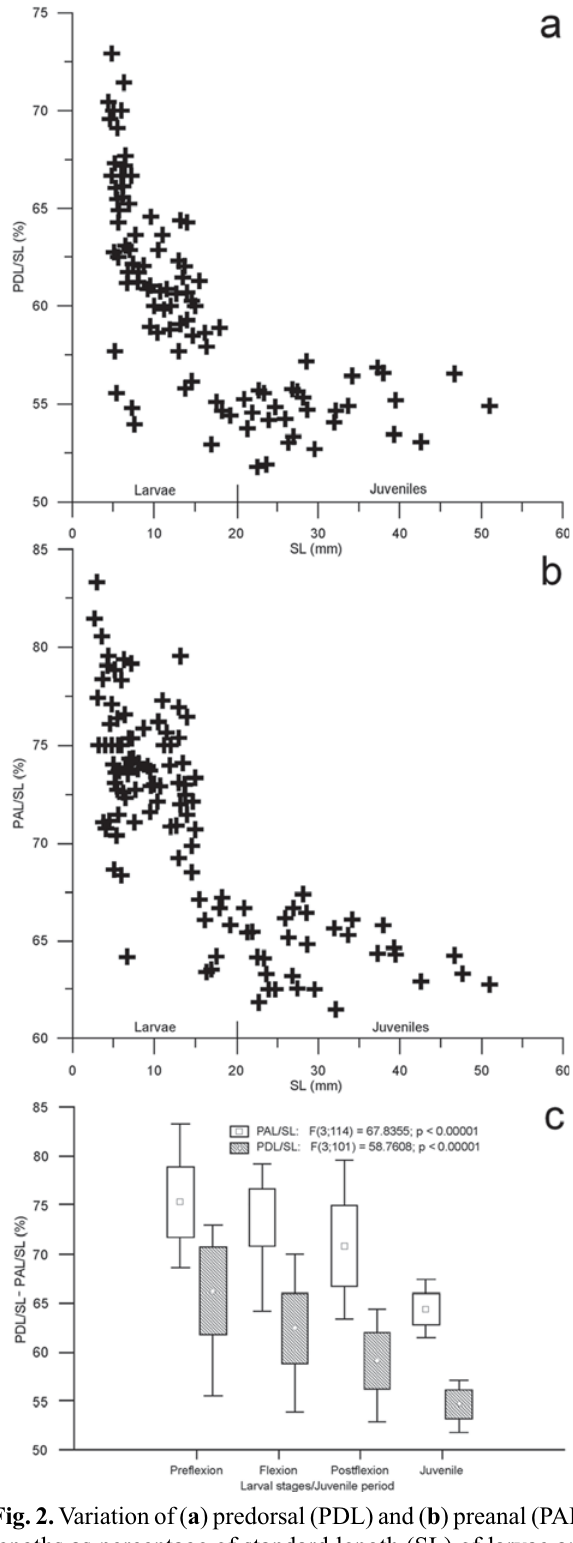
Fig. 2. Variation of ( a ) predorsal (PDL) and ( b ) preanal (PAL) lengths as percentage of standard length (SL) of larvae and juveniles of Anchoviella vaillanti , and ( c ) mean values for PDL/SL and PAL/SL for larval stages (preflexion, flexion and postflexion) and juveniles. Mean values; box: mean±standard deviation, whisker: minimum-maximum